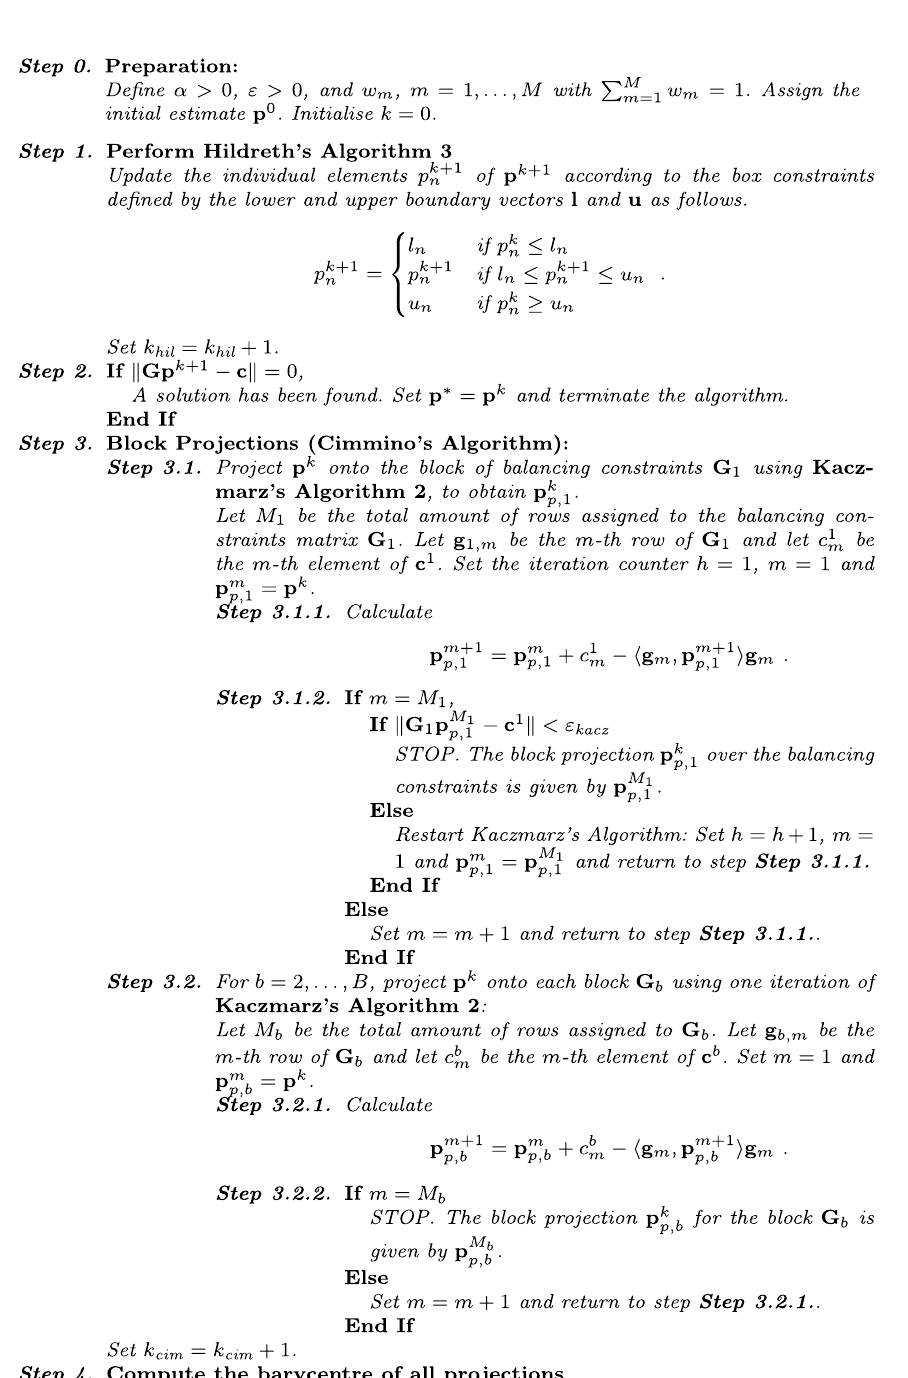
Algorithm 5 (ACIM: Main Algorithm for Parallel MRIO